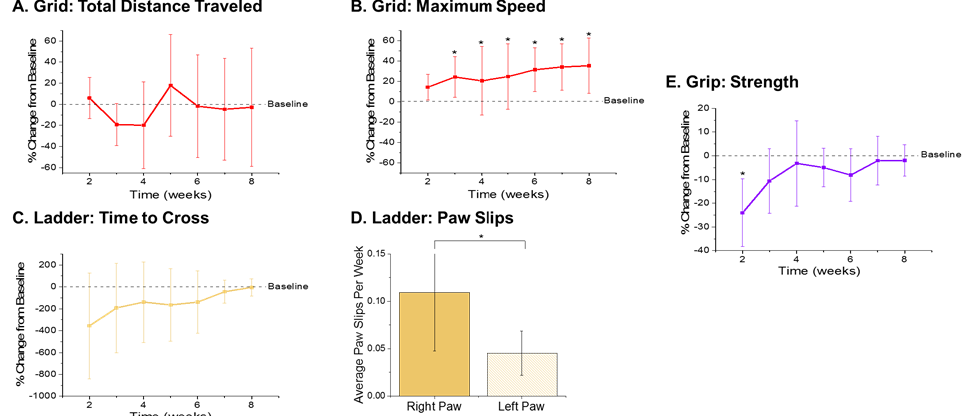
Figure 3. Motor Behavior Metrics. Gross motor function metrics from the open field grid test